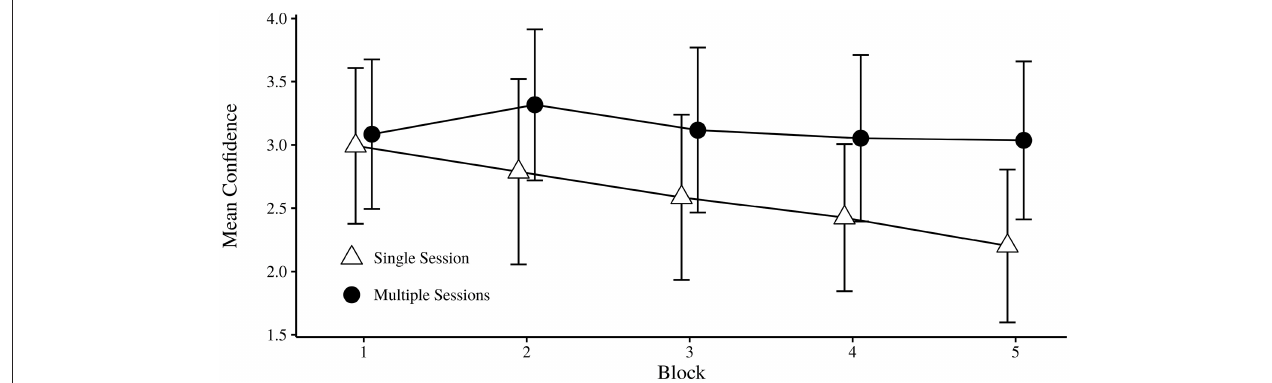
FIGURE 4 | Mean confidence for each condition over successive blocks. Error bars indicate 95%